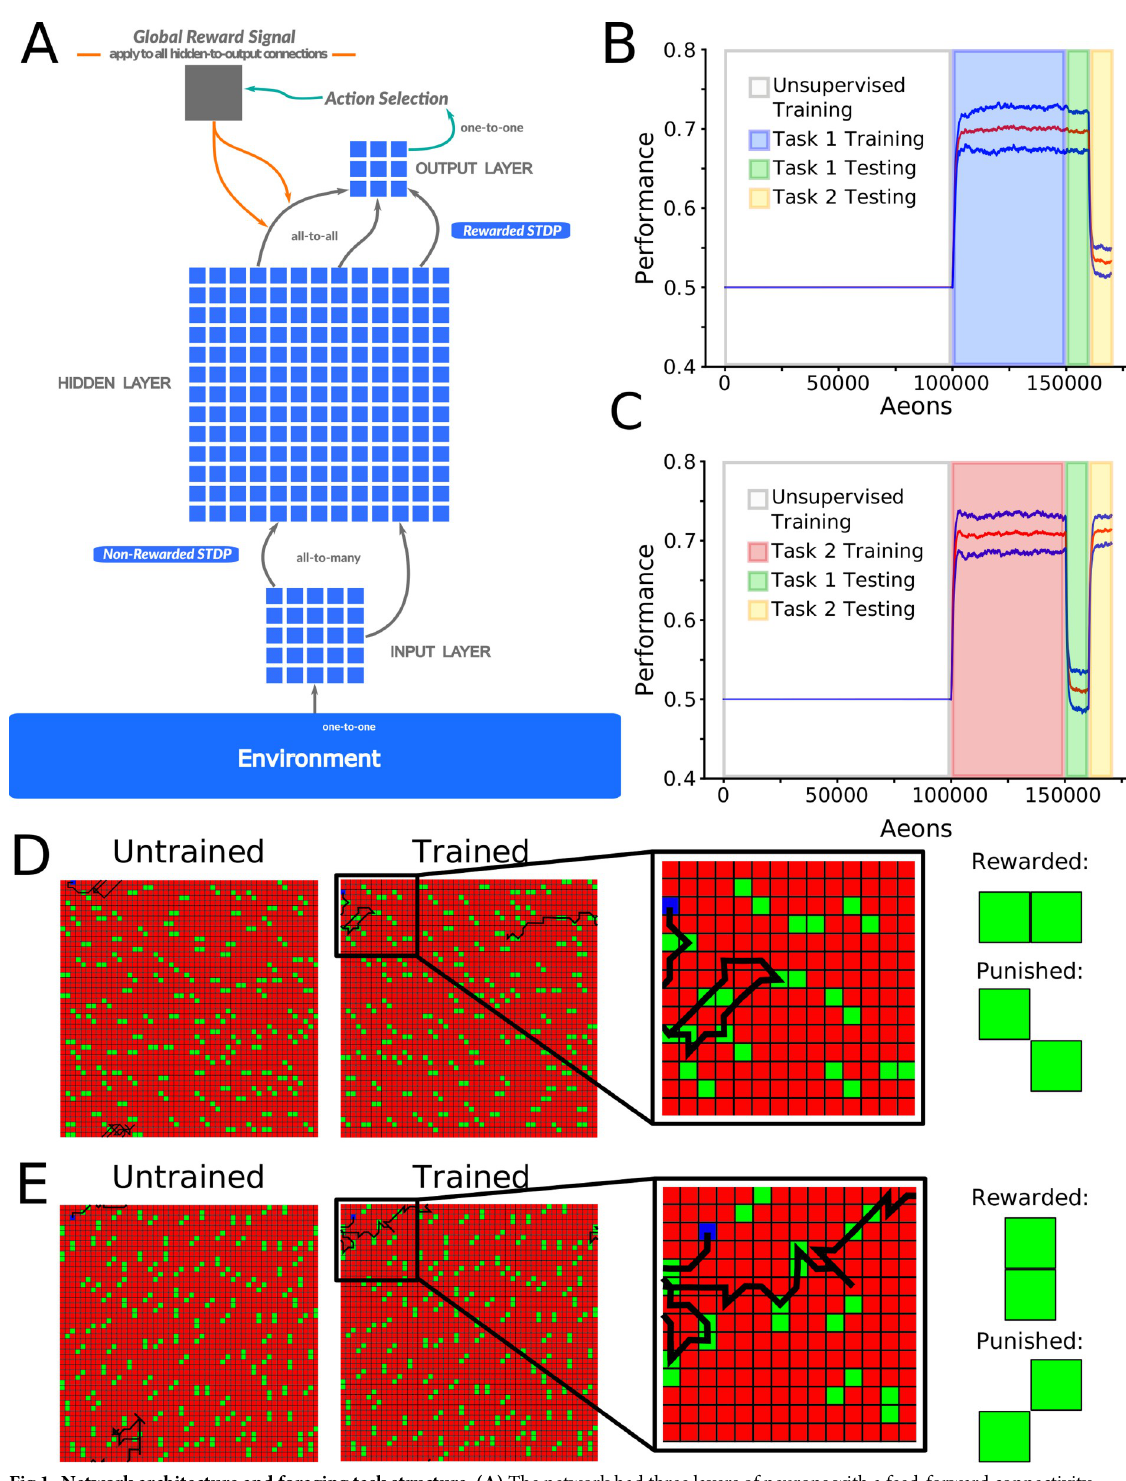
Fig 1. Network architecture and foraging task structure. (A) The network had three layers of neurons with a feed-forward connectivity scheme. Input from virtual environment was simulated as a set of excitatory inputs to the input layer neurons (“visual field”- 7x7 subspace of 50x50 environment) representing the position of food particles in an egocentric reference frame relative to the virtual agent. Each hidden layer neuron received an excitatory synapse from 9 randomly selected input layer neurons. Each output layer neuron received one excitatory and one inhibitory synapse from each hidden layer neuron. The most active neuron in the output layer (size 3x3) determined the direction of